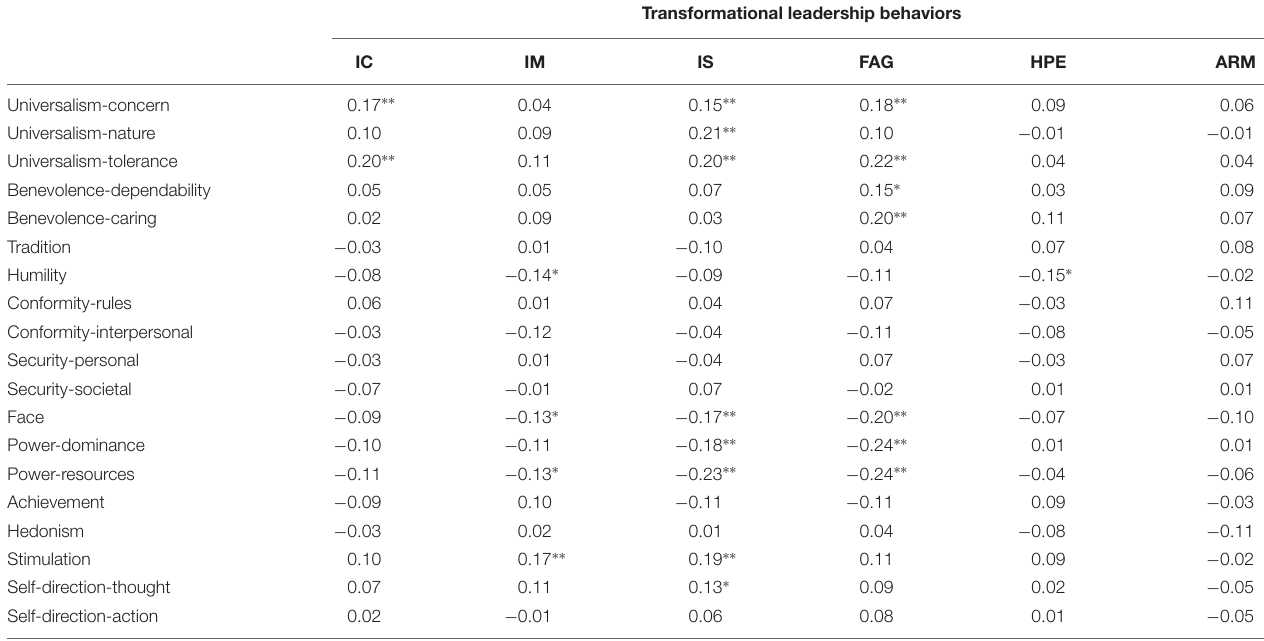
TABLE 4 | Bivariate correlations between basic values and transformational leadership behaviors ( N = 266 coaches).